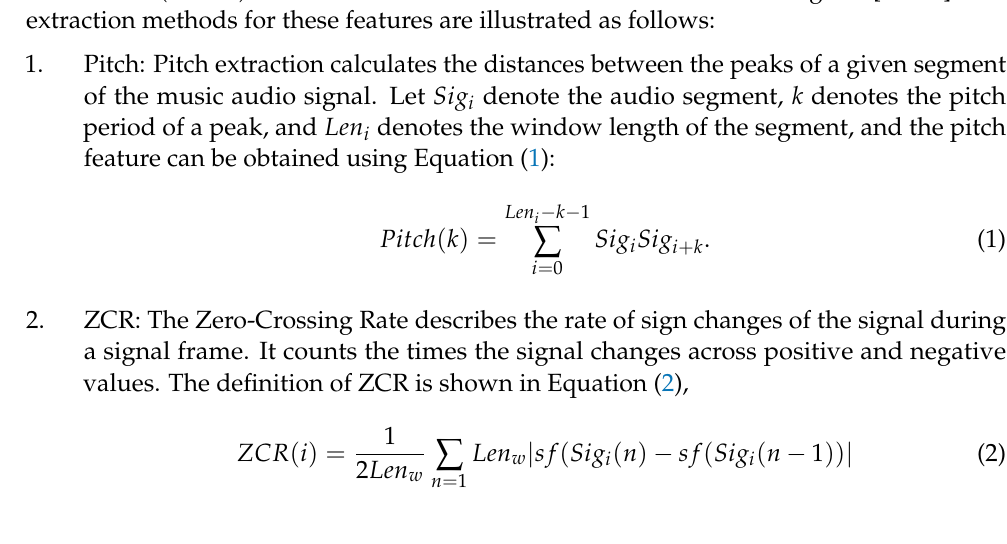
Figure 2. The emotion valence-arousal